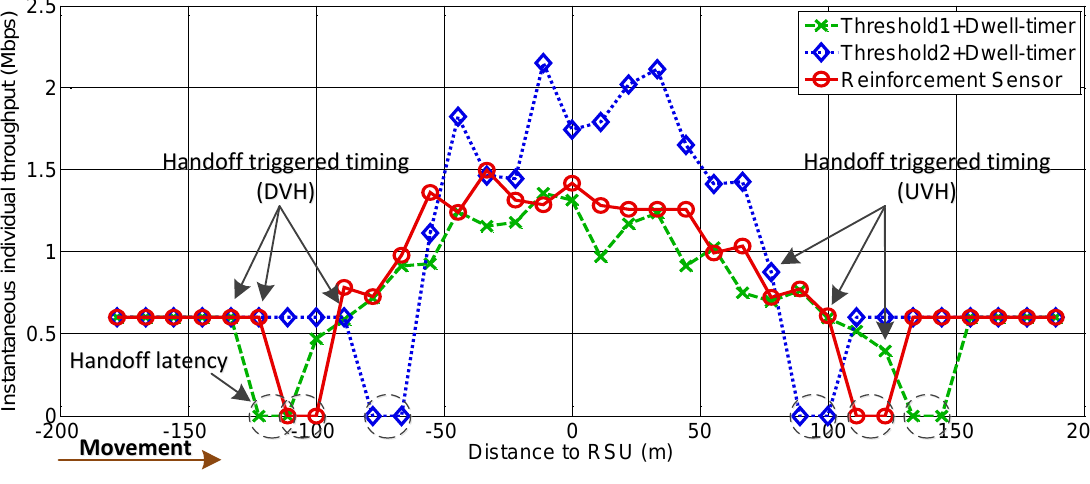
Figure 8. Instantaneous individual throughput vs. distance to RSU (arrival rate = 0.4 veh/s).